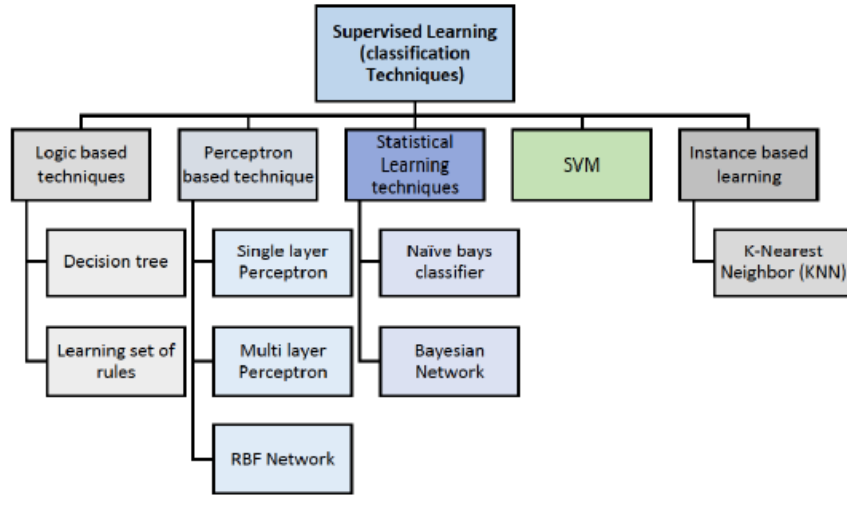
Figure 2. Supervised learning classification techniques